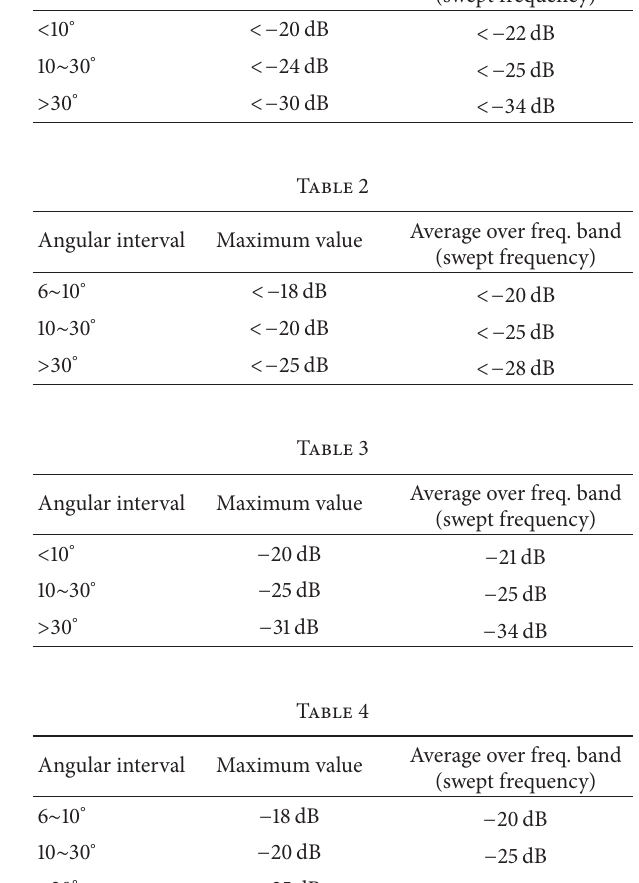
Angular interval Maximum value Average over freq. band